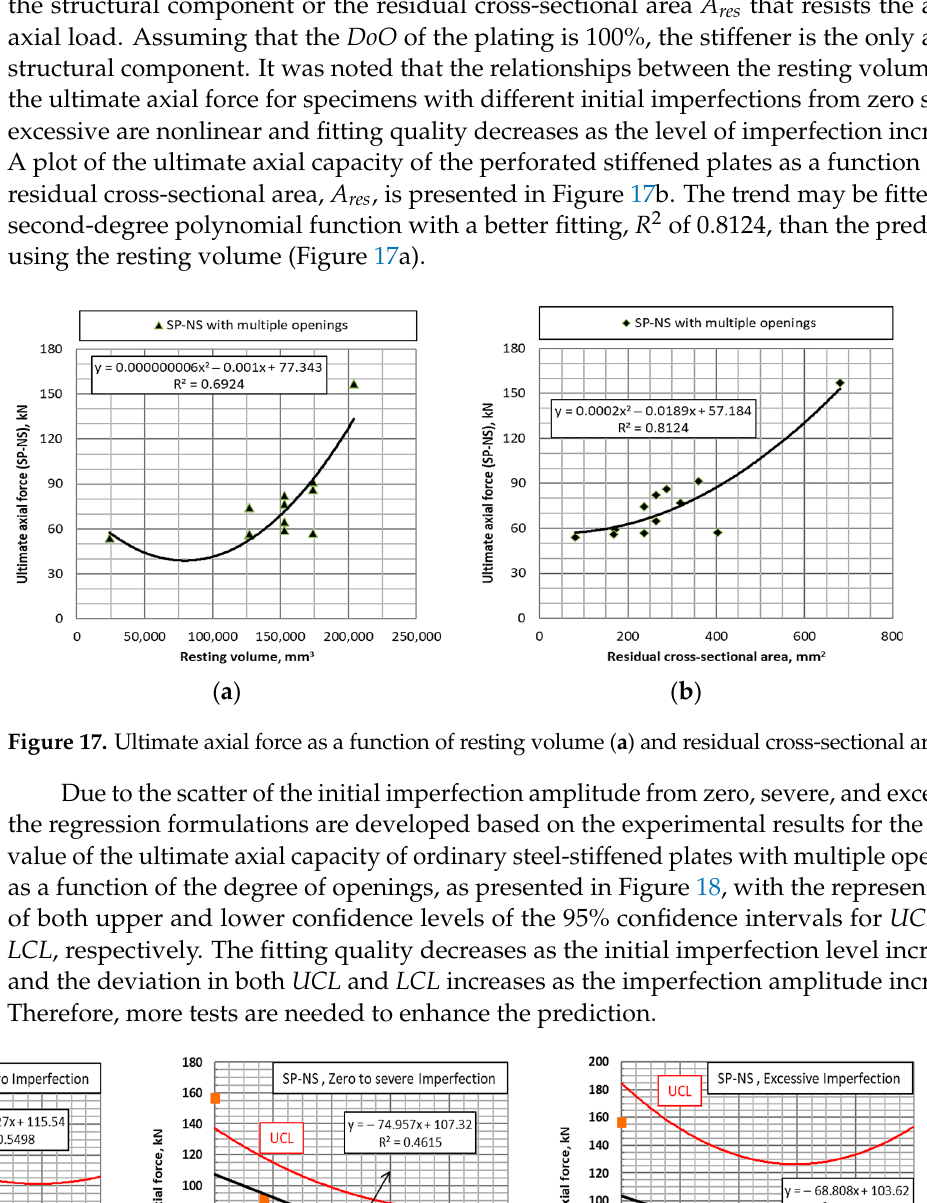
Figure 16. Capacity reduction as a function of DoO for different opening numbers, EXP ( a ) and FE ( b ).